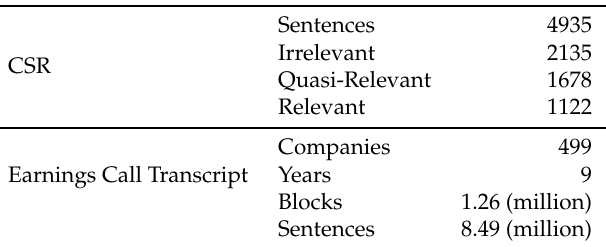
Table 1. Dataset Summary.